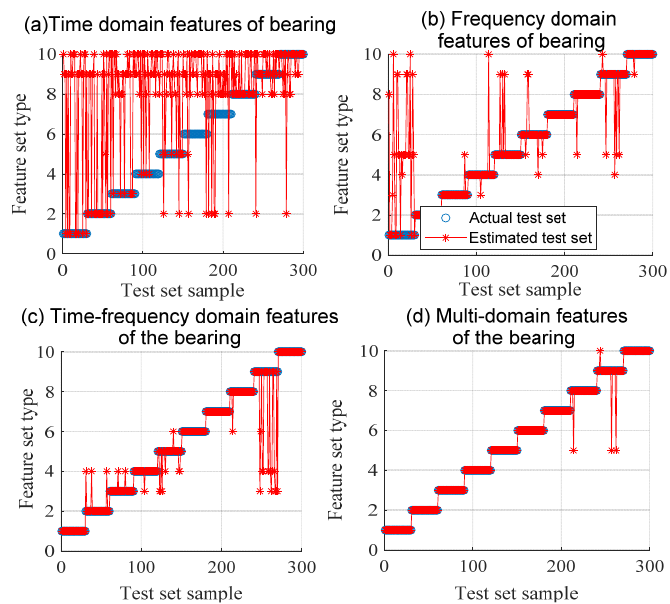
Figure 6. Comparison of diagnoses of the bearing’s time-domain, frequency-domain, time-frequency-domain, and multi − domain features.